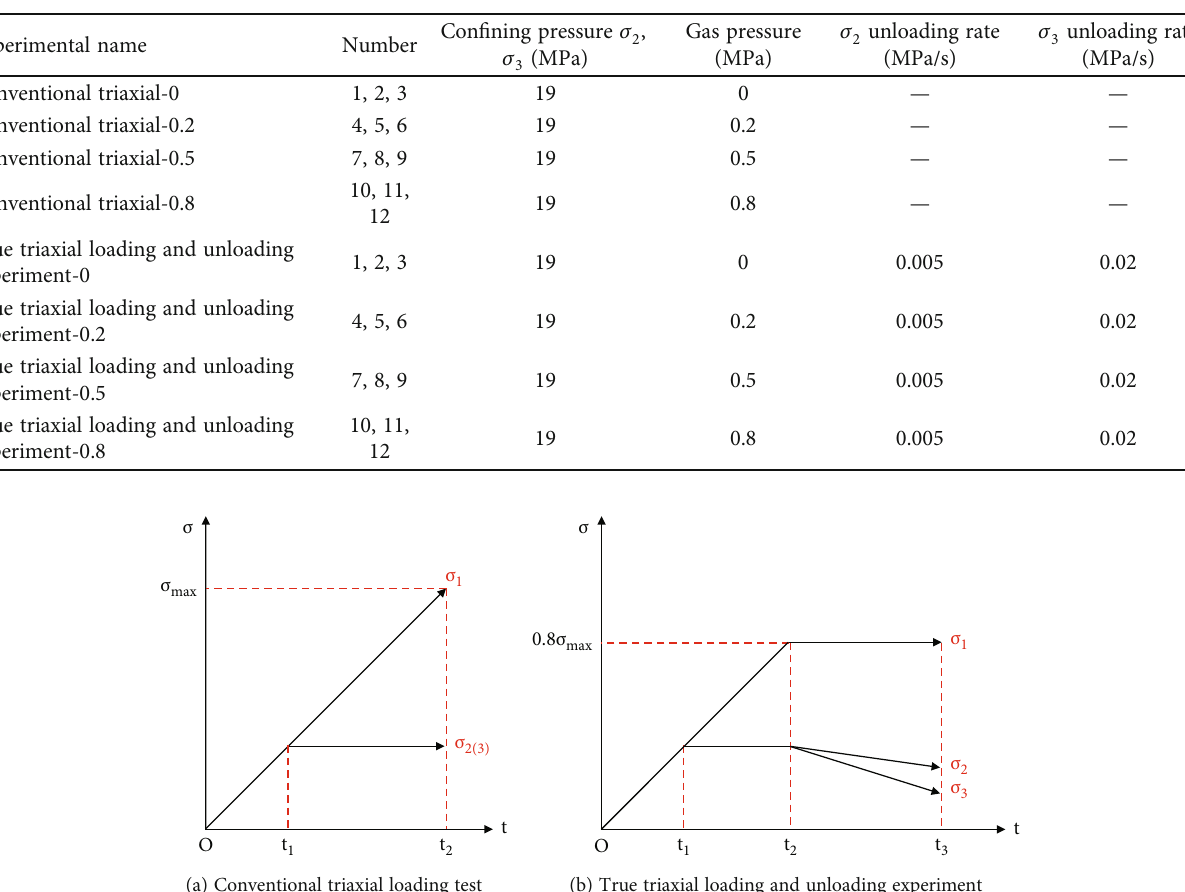
Figure 2: Experimental samples. Table 1: Experimental condition.